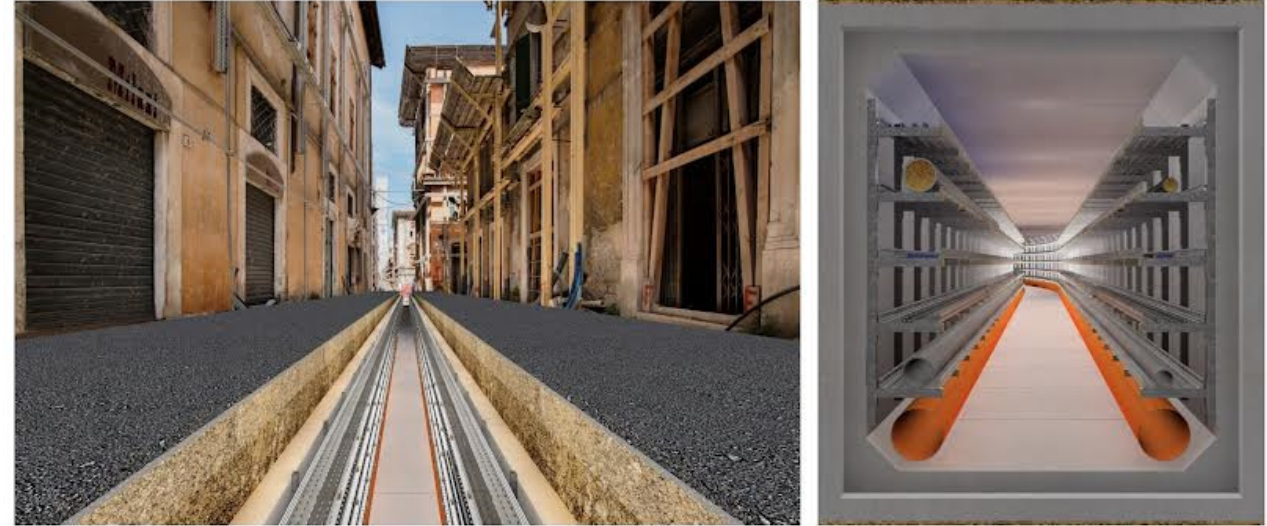
Figure 1. ( Left ), reconstruction of the duct in a street in the historic center of L’Aquila; ( right ), 3D view of the duct.